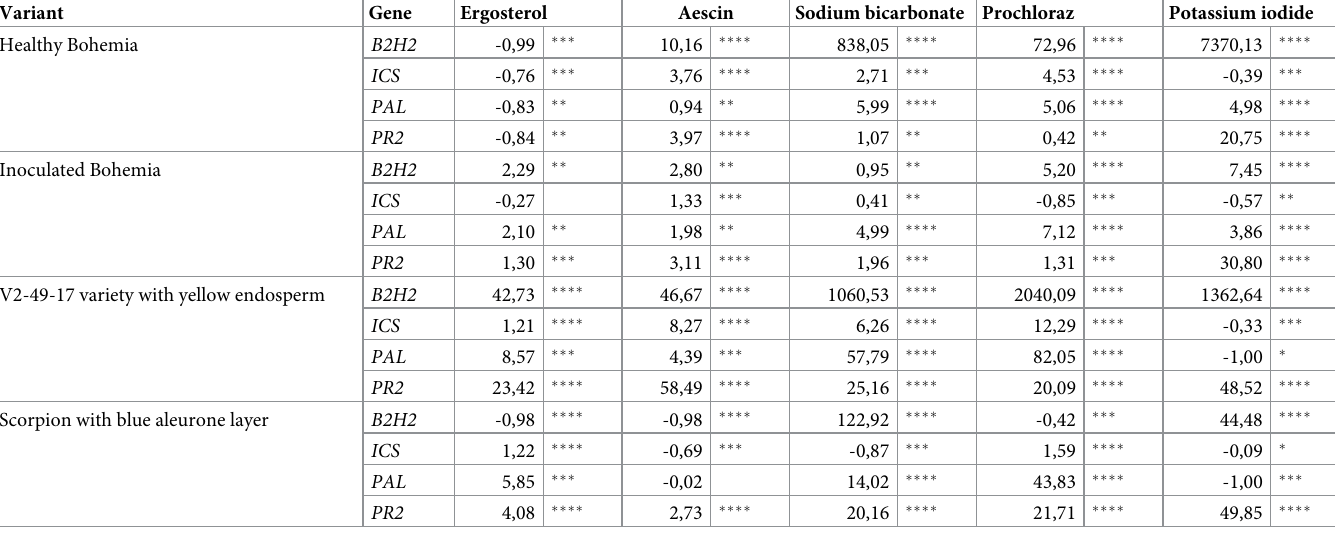
Significant fold differences between water control and experimental treatments are indicated by asterisks ( P < 0.05 ( � ); P < 0.01 ( �� ); P < 0.001 ( ��� ); P < 0.0001 ( ���� ). The statistical analyses were carried out separately within each gene and